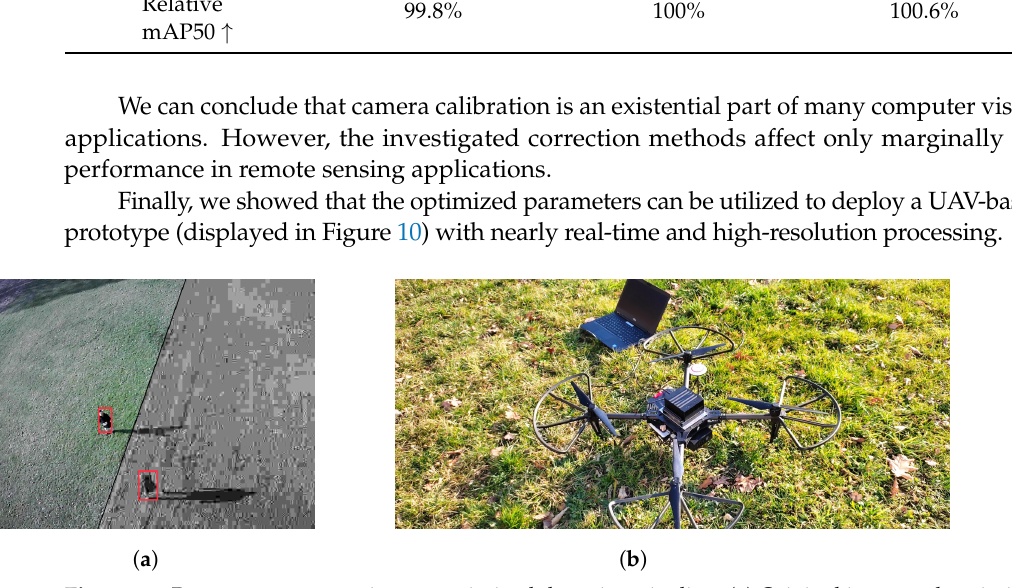
Figure 10. Prototype system using an optimized detection pipeline. ( a ) Original input and optimized input; ( b ) Detection pipeline onboard a DJI Matrice